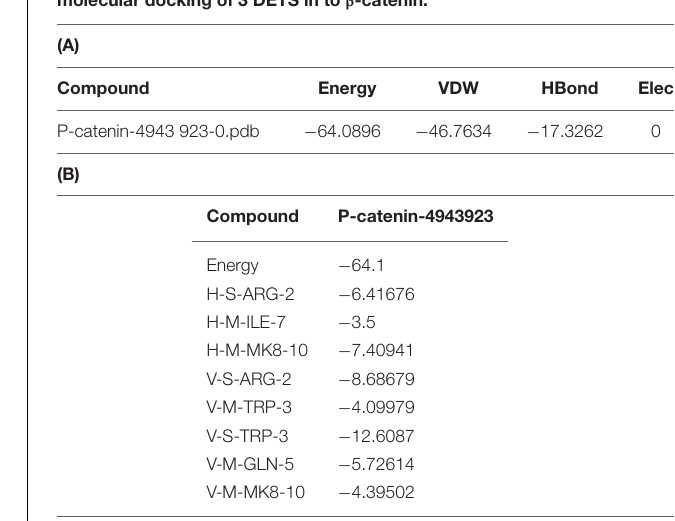
(A) Fitness table and (B) Interaction